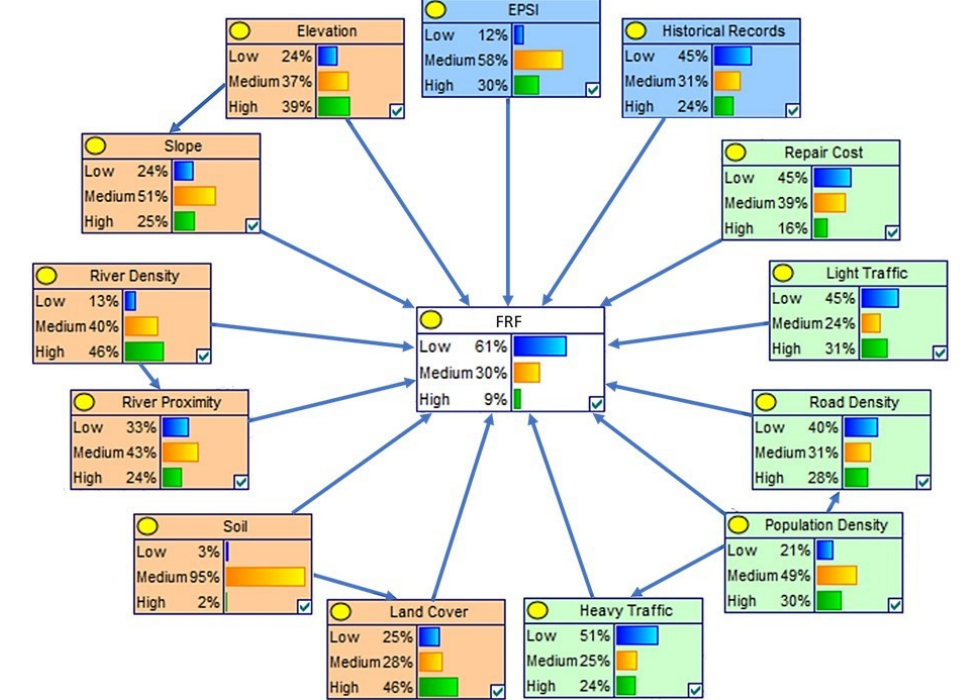
Figure 6. BN model for flood risk assessment of road infrastructures